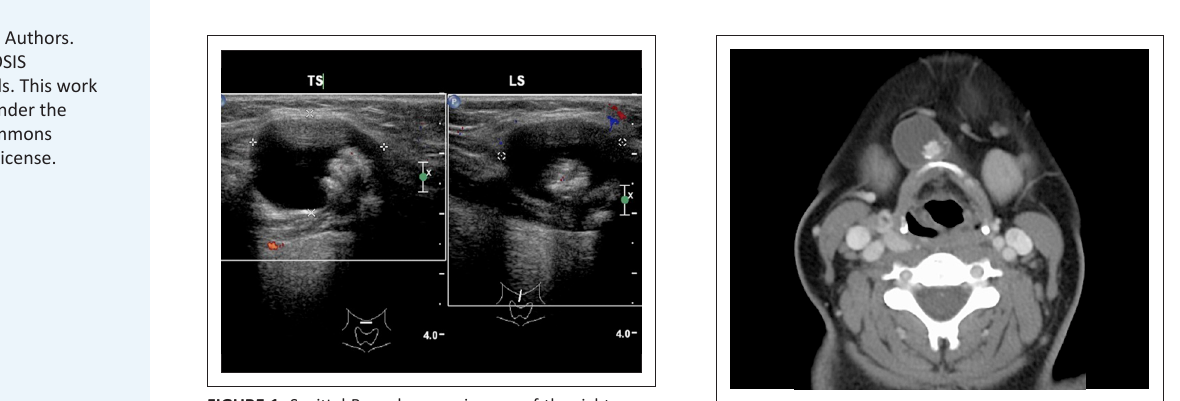
FIGURE 1: Sagittal B-mode sonar images of the right para- median anterior neck mass, demonstrating the thyroglossal duct cyst (TDC) with intracystic postero-inferior echogenic nodule. Posterior acoustic shadowing indicates calcification of the nodule.